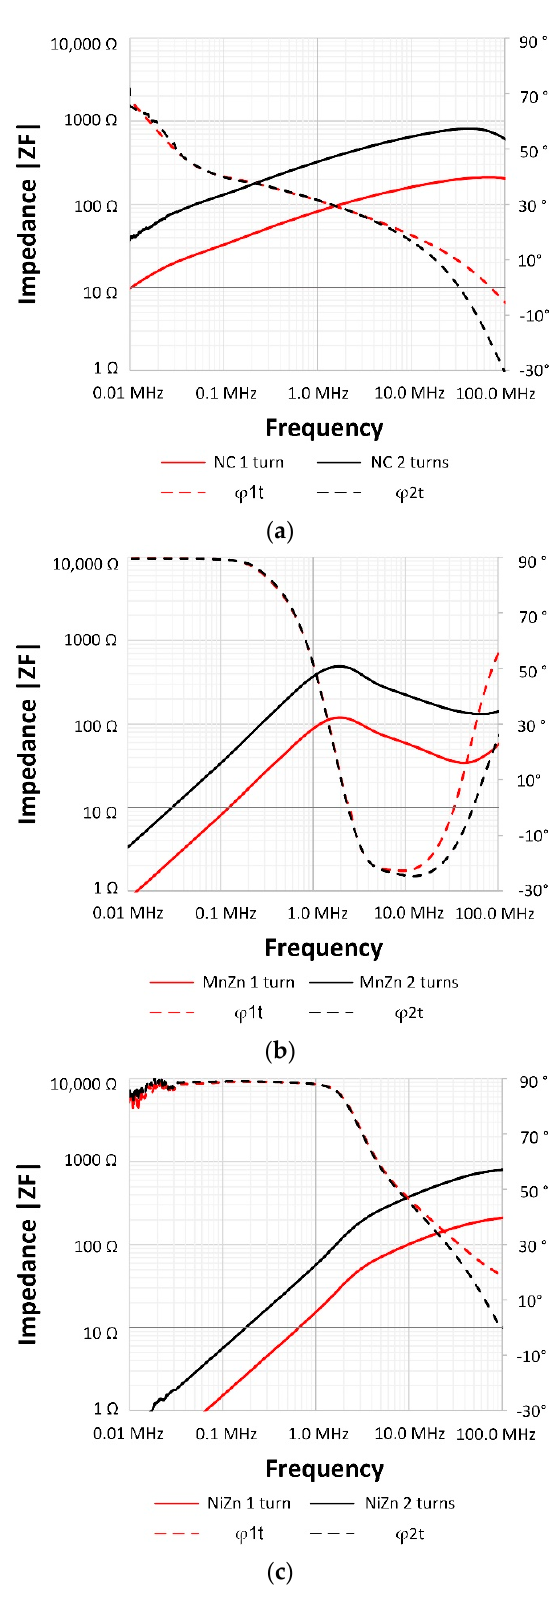
Figure 9. Comparison of the magnitude impedance and angle phase of X L / R of the NC sleeve ferrite core compared to MnZn and NiZn by winding around them one and two turns: ( a ) NC sleeve ferrite core; ( b ) MnZn sleeve ferrite core; ( c ) NiZn sleeve ferrite